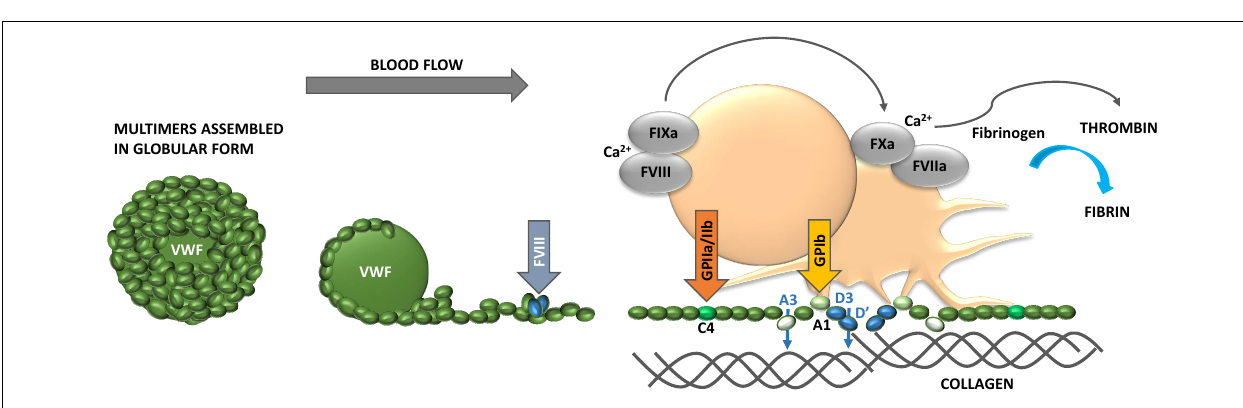
FIGURE 2 | Properties of von Willebrand factor (VWF). VWF obtains globular conformation under static conditions, while it unfolds and elongates under blood flow. The higher the hematocrit, the faster the flow conditions and the smaller the vessel lumen (vasoconstriction), the higher the shear forces and contribution of adhesive platelets. VWF multimer size is controlled by ADAMTS13. While unfolding VWF exposes domains with binding sites for several extracellular proteins, including collagen, and glycosaminoglycans (GAG), and platelet glycoprotein (GP) Ib and GPIIb/IIIa to foster platelet adhesion and activation. VWF carries coagulation